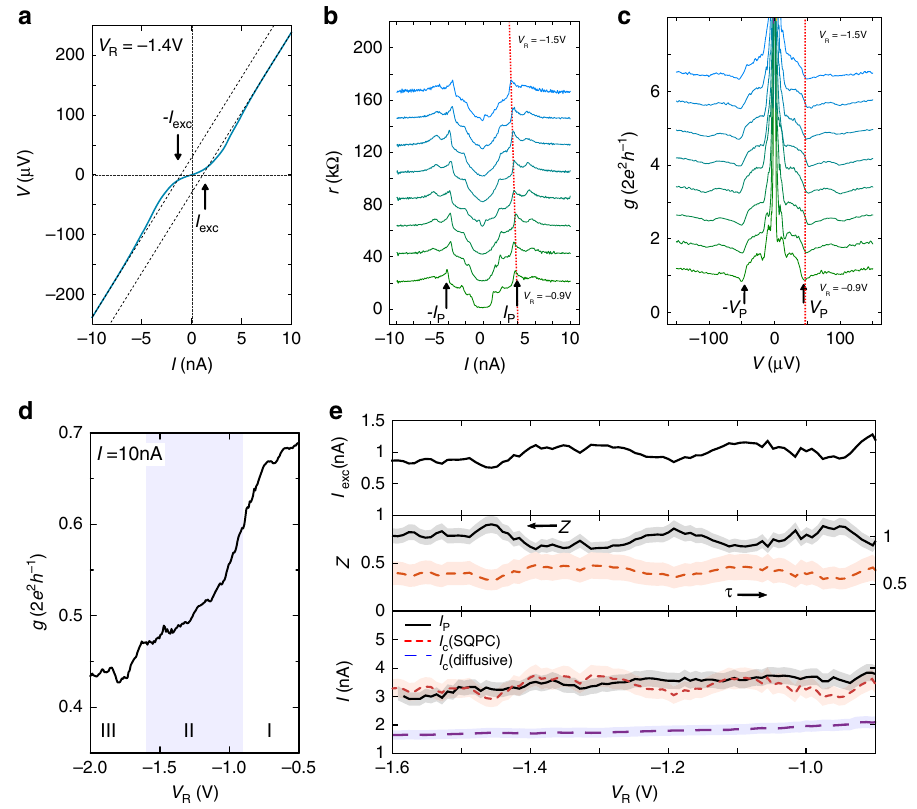
Fig. 3 Superconducting quantum point contact in regime II. a Representative V – I curve in regime II ( V R = − 1.4 V). The rounded supercurrent is clearly visible. The excess current is denoted I exc . b r versus I for different V R . I P , inferred from the sharp peak in r , is indicated. The change of I P with V R is highlighted by a dashed line as guide-to-the-eye. The curves are offset by 10 k Ω . c g versus V for different V R . V P ≈ 44 μ V is indicated with arrows and a dashed line as guide-to-the-eye. The curves are offset by 0.2 (2 e 2 h − 1 ). d g for I = 10 nA. e top panel: I exc as a function of V R . Middle panel: Barrier strength Z (solid, black line) and normal state transmission τ (dashed, red line) as obtained from BTK. Bottom panel: I P (solid, black line) and critical current I c as expected for a SQPC (short, red dashes). For comparison, I c expected for a diffusive junction with conductance g is shown (blue dashes). Shaded regions indicate the standard